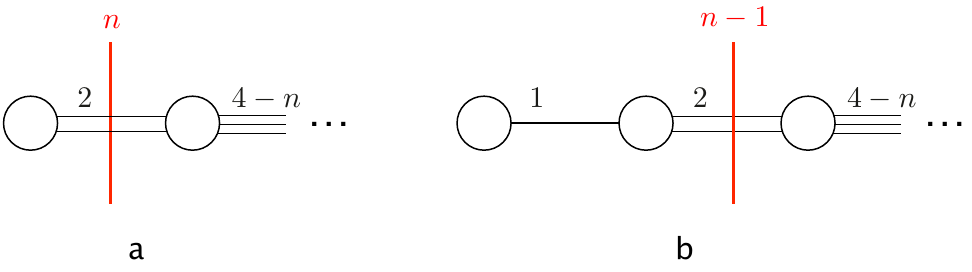
Figure 4 . An SU(2) piece of the quiver.